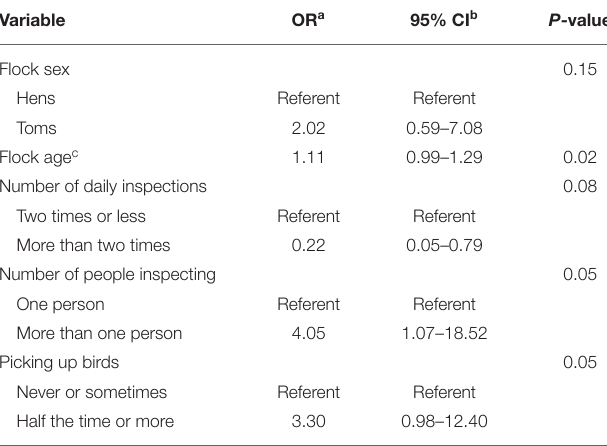
TABLE 4 | Final logistic regression model for the presence of HN injuries ( N = 62, pR 2 = 0.23, alpha = 0.05).